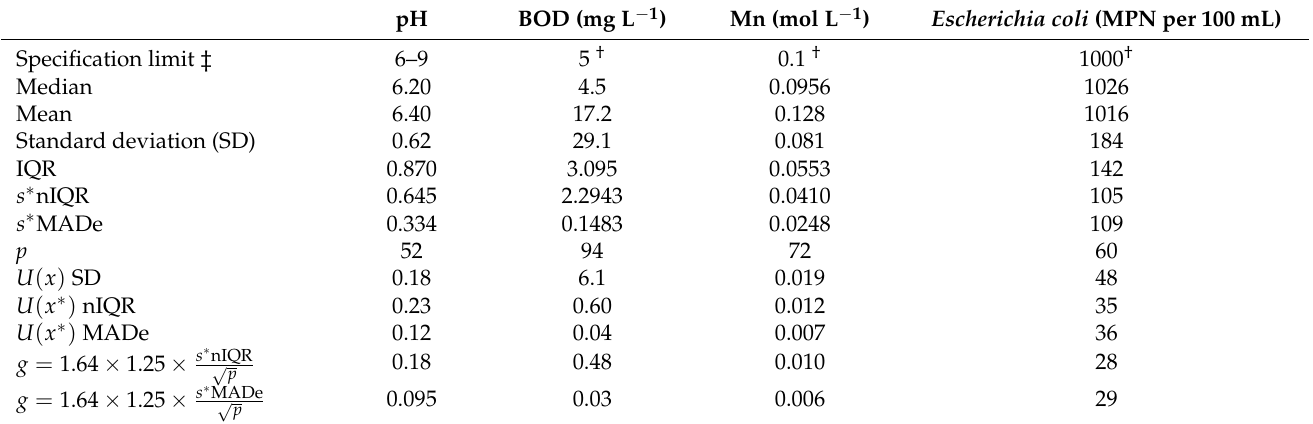
Table 2. Statistical results.